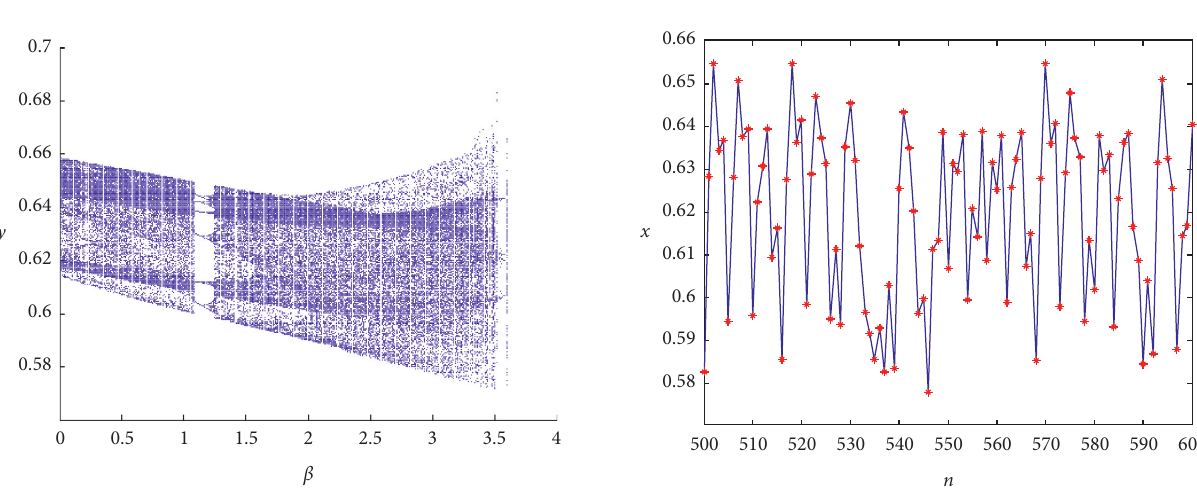
Figure 10: Lyapunov spectrum versus β when a � 1, b � 1.14, c � 2.93, d � 1.3, e � 0.21, f � 0.1, g � 0.35, h � 2, α � 0.05, c � 0.5.